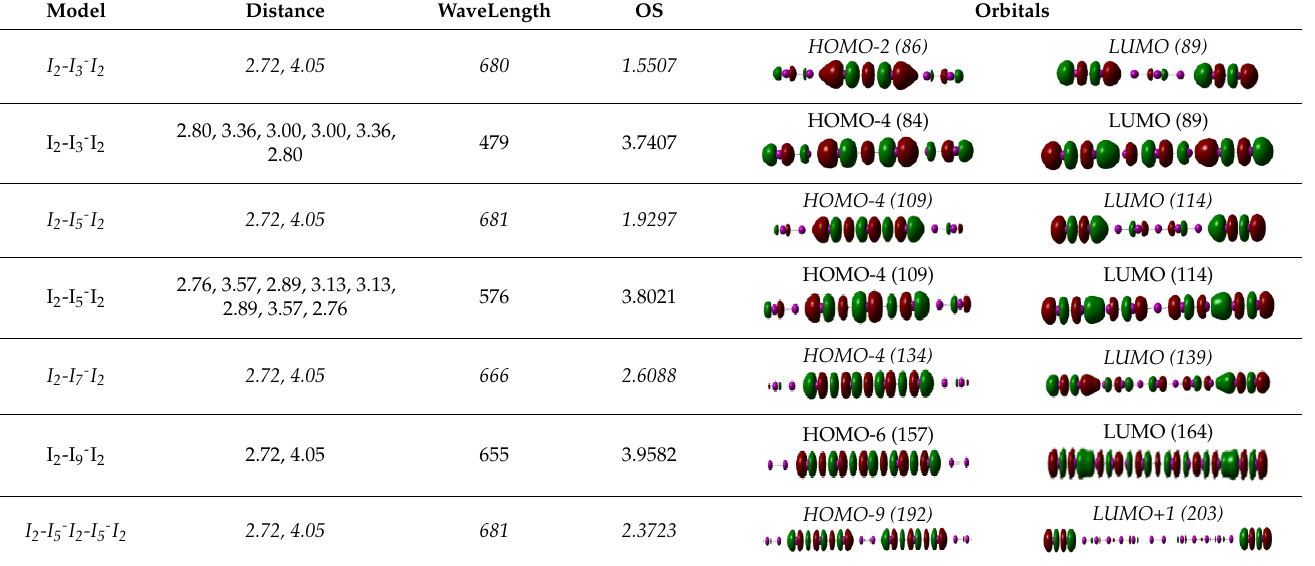
Table 3. I-I distances (Å), wavelengths for the major maximum in the visible region (nm), oscillator strengths (OS) and relevant molecular orbitals on linear I n- I 2 models from TD-DFT (B3LYP/def2- SV(P)) calculations. Data shown in italics are for structures built with intramolecular I-I distances known experimentally for I 2 in solid state (2.72 Å), and with intermolecular distances arbitrarily set at 4.05 Å (i.e., at the limit of the sum of van der Waals radii)–without any further geometry optimization. All other data are from fully optimized geometries. OS